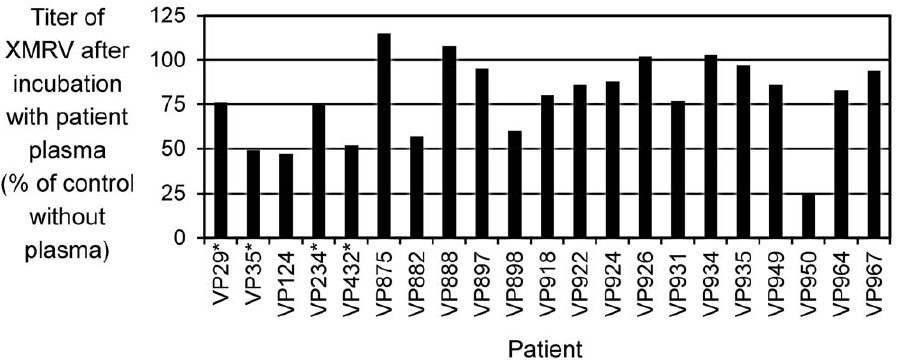
Figure 1. XMRV neutralization by prostate cancer patient plasma. Patient numbers are listed at bottom with asterisks indicating those that had previously tested positive for XMRV (see Discussion for details). The XMRV titer was determined after incubation of a small amount of XMRV with undiluted plasma, or with culture medium as a control, as described in Materials and Methods. Results are shown as the ratio of the XMRV titer after incubation with plasma to that after incubation with culture medium, expressed as a percentage. Note that some values exceed 100%, indicating enhancement of XMRV infection by these plasma samples.